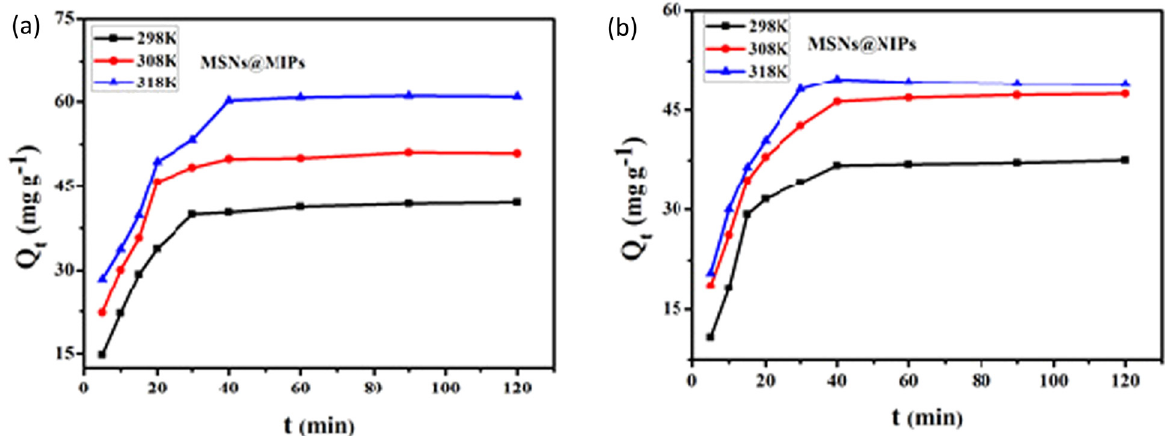
Figure 8: Adsorption kinetics of ( a ) MSNs@MIPs and ( b ) MSNs@NIPs.